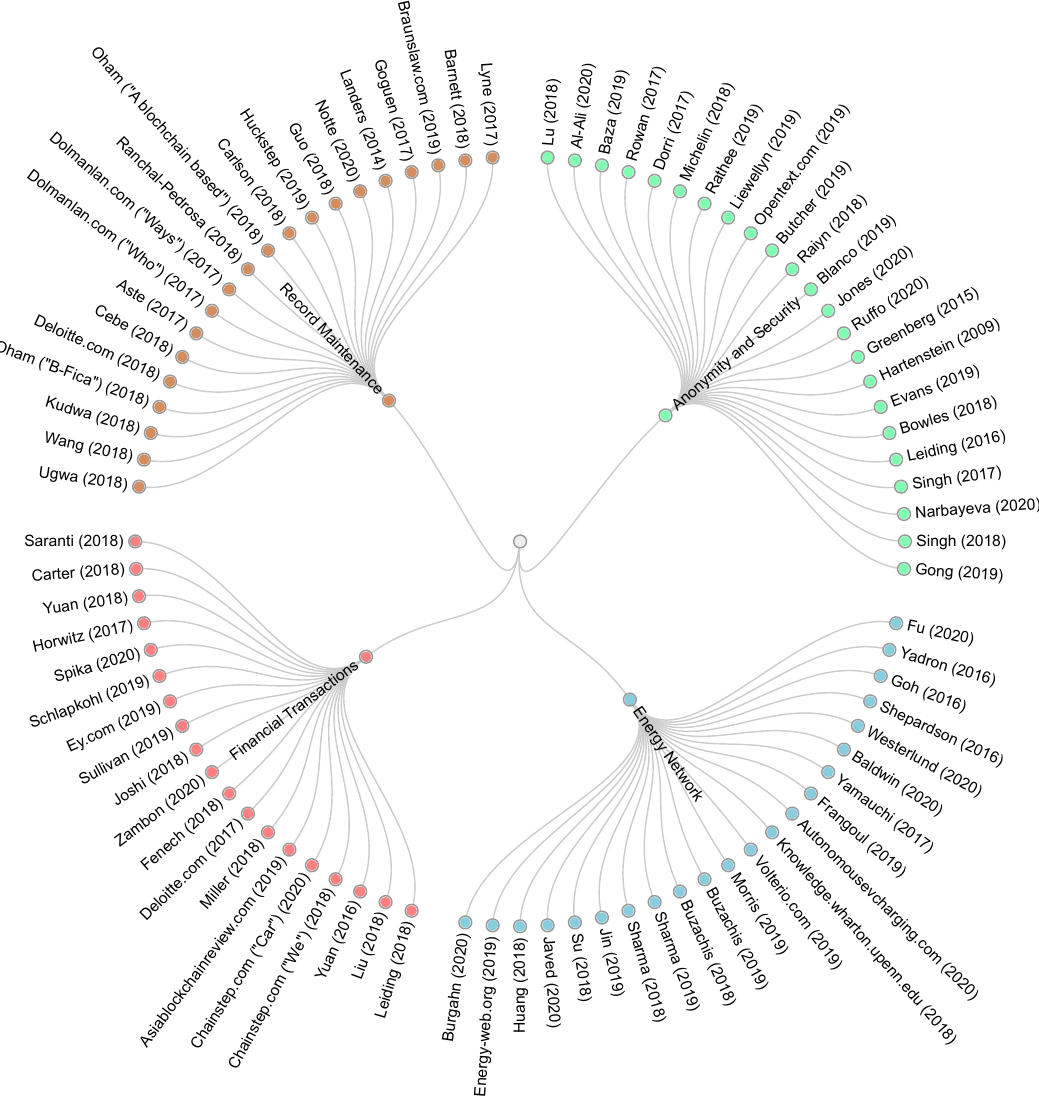
Figure 5. A circular dendrogram demonstrating the leading research activities in each